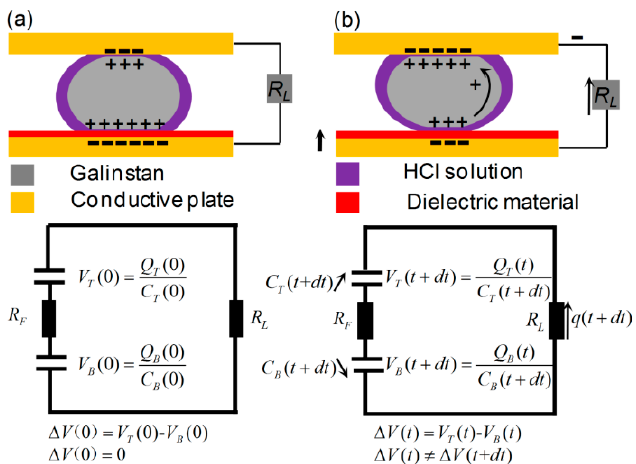
Figure 6. The equivalent electrical circuit at the very moment ( a ) when the EDLC system is in a state of equilibrium and ( b ) when the EDLCs system is in state of non-equilibrium.